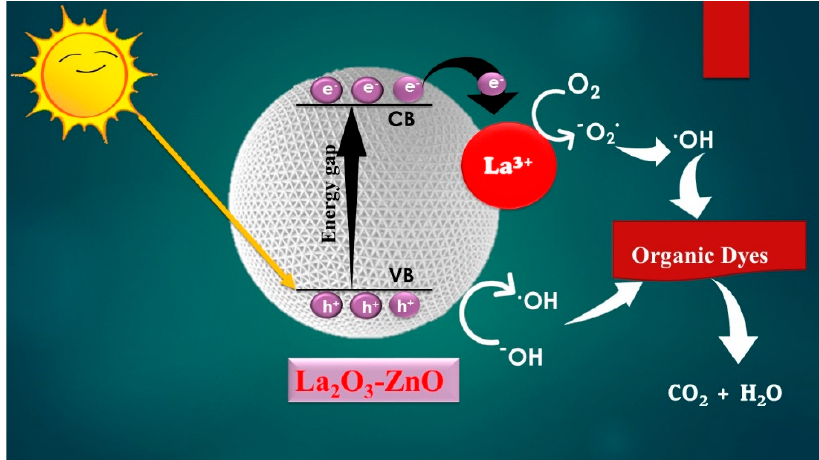
Figure 12. Photocatalytic mechanism of La 2 O 3 -ZnO nanostructured